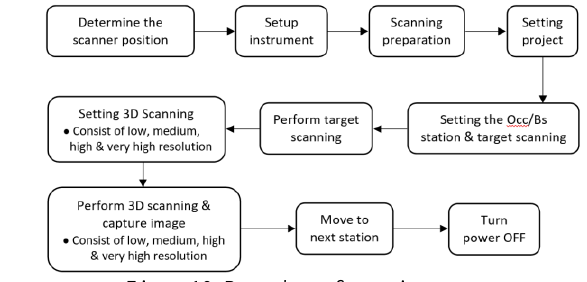
Figure 19. Procedure of scanning